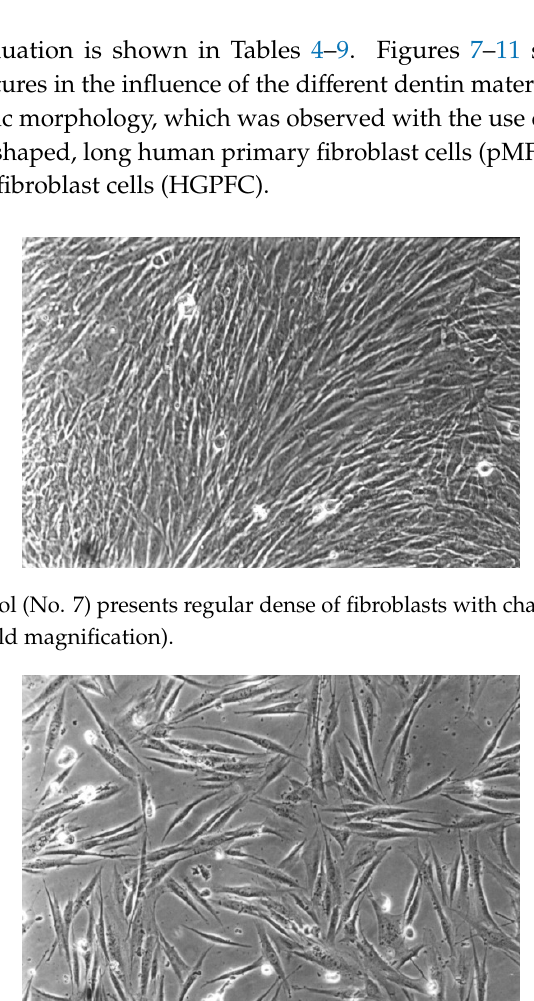
control; (Sequentially applied vs. Adhesive * viable: p = 0.005, sequentially applied vs. Heliobond **